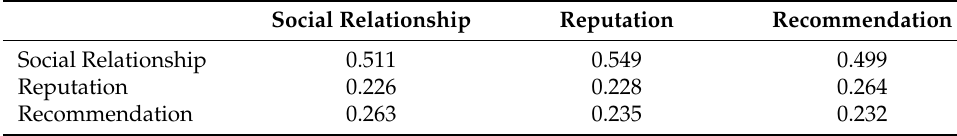
Table 12. Normalised FCM for scenario 2.